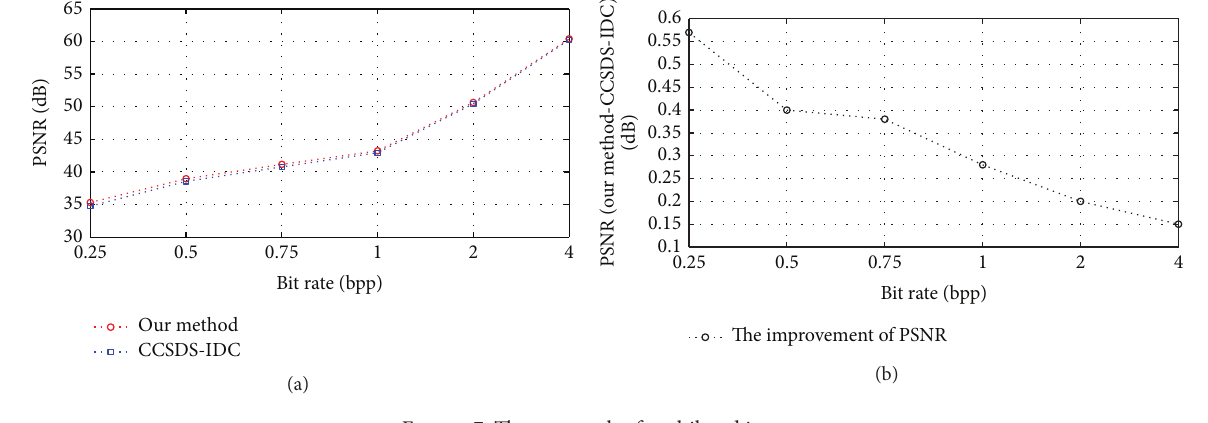
Figure 7: The test result of multiband